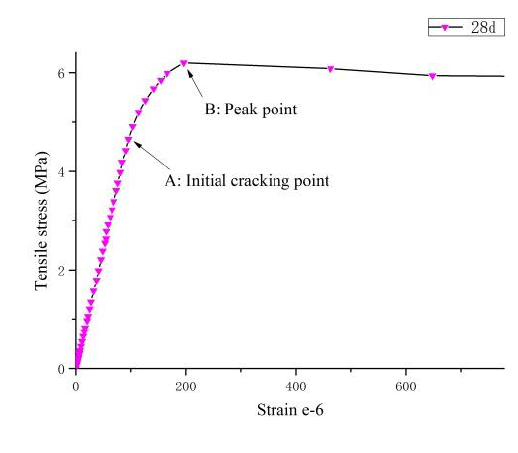
Figure 6. Full axial tensile stress–strain curve of RPC at 28-day curing age.